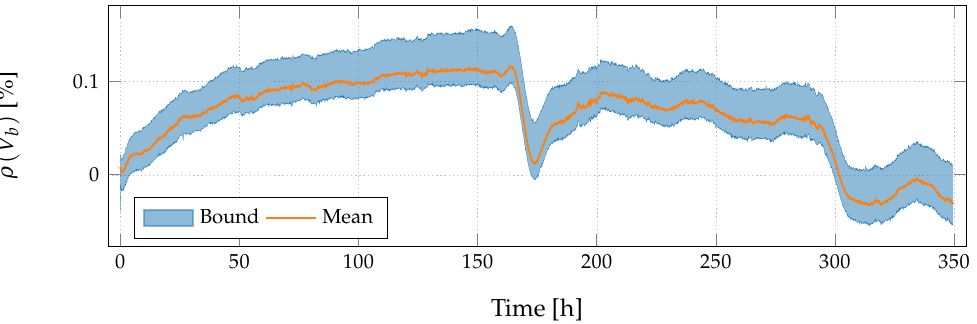
Figure 19. Relative error of the model on the PhyNode load evaluation